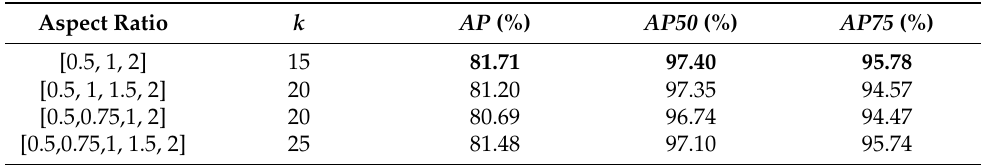
Table 6. Analysis of different anchor aspect ratios on the UED